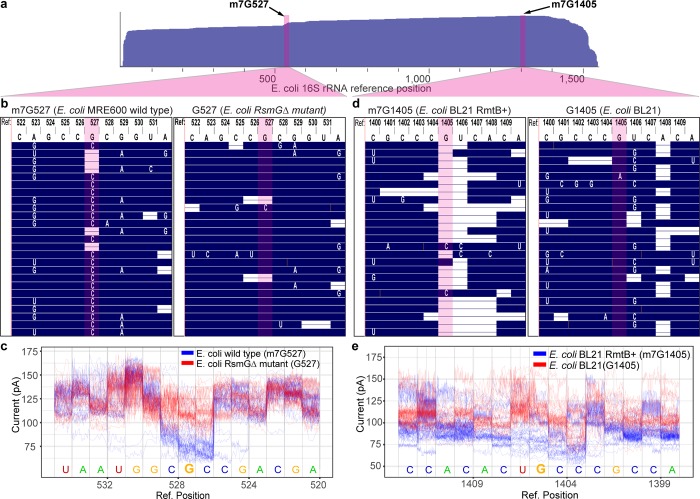
Detection of 7mG modifications in E. coli 16S rRNA.(a) Diagram showing the positions along E. coli 16S rRNA that correspond to the expanded sequence alignments in panels b-e. Arrows indicate the positions of G527 and G1405 in the E. coli reference. (b) Alignment of nanopore RNA sequence reads proximal to position 527 of E. coli 16S rRNA. Numbered letters at the top represent DNA bases in the reference 16S rRNA gene. Blue regions in the body of the panel denote agreement between reference DNA bases and nanopore RNA strand base-calls. White letters denote base call differences between the reference and the nanopore reads, and horizontal white bars represent base deletions in the nanopore RNA reads. Columns highlighted in red correspond to position 527. The left inset is E. coli str. MRE600 (wild type) 16S rRNA (m7G527), and the right inset is RsmG mutant strain 16S rRNA (canonical G527). (c) Nanopore ionic current traces proximal to position 527 of the E. coli 16S rRNA reference. Blue traces are for wild type E. coli 16S rRNA translocation events bearing m7G at position 527. Red traces are for mutant strain 16S rRNA translocation events bearing a canonical G at position 527. (d) Alignment of nanopore RNA sequence reads proximal to position 1405 of E. coli 16S rRNA. Use of colors, shapes, and letters are as described for panel (b). The left inset is engineered mutant E. coli str. BL21 (RmtB+) 16S rRNA (m7G1405); the right inset is E. coli str. BL21 16S rRNA (G1405). (e) Nanopore ionic current traces proximal to position 1405 of the E. coli 16S rRNA reference. Blue traces are for mutant strain 16S rRNA translocation events bearing m7G at position 1405. Red traces are for wild type 16S rRNA translocation events bearing a canonical G at position 1405.